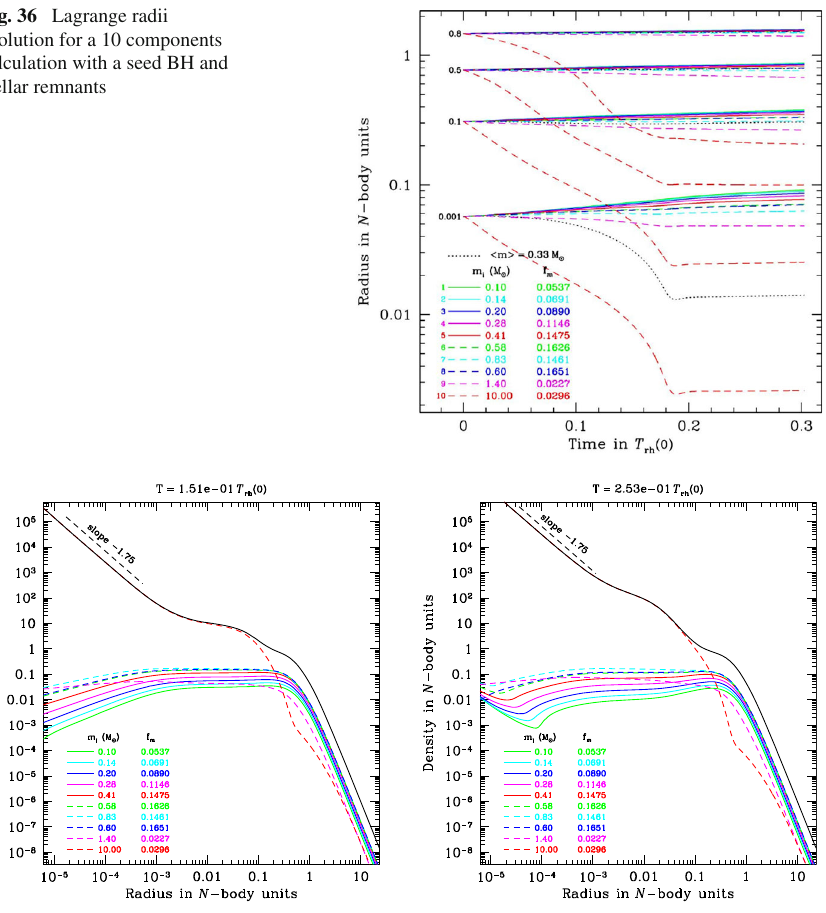
Fig. 37 Density profiles in a multi-mass system with seed BH before and after core-collapse (see